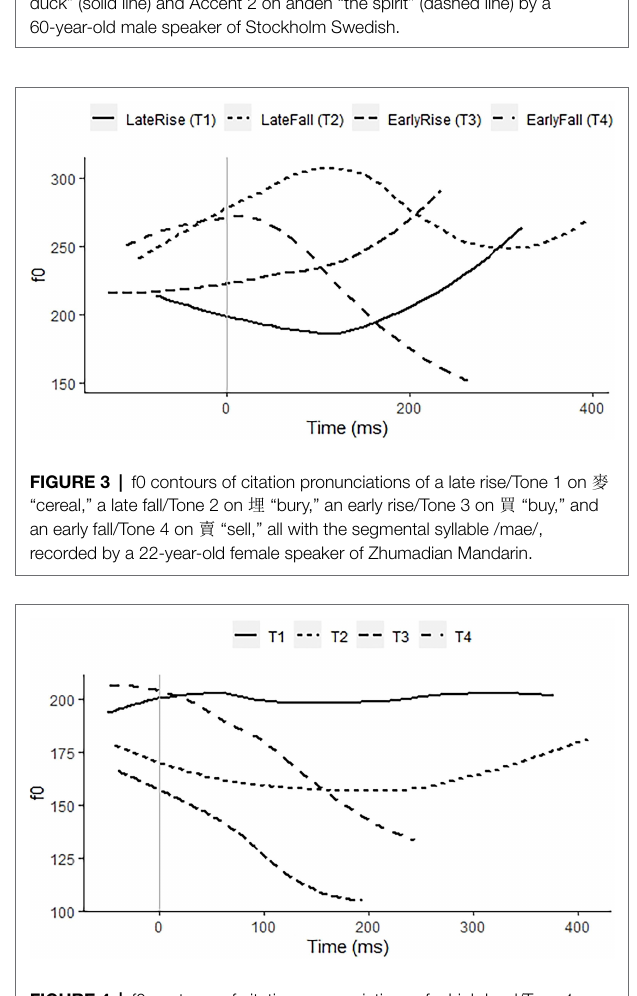
FIGURE 4 | f0 contours of citation pronunciations of a high level/Tone 1 on 媽 “mother,” a rise/Tone 2 on 麻 “hemp,” a low tone/Tone 3 on 馬 “horse,” and a high falling/Tone 4 on 罵 “scold,” all with the segmental syllable/ma/, recorded by a 40-year-old female speaker of Taiwan